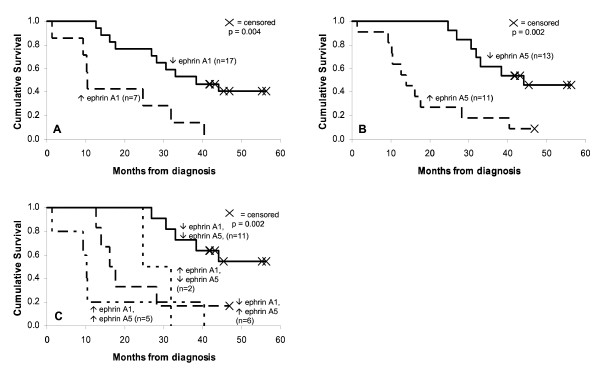
Plots showing association between high and low levels of ephrin A1 or ephrin A5, in conjunction, with survival.